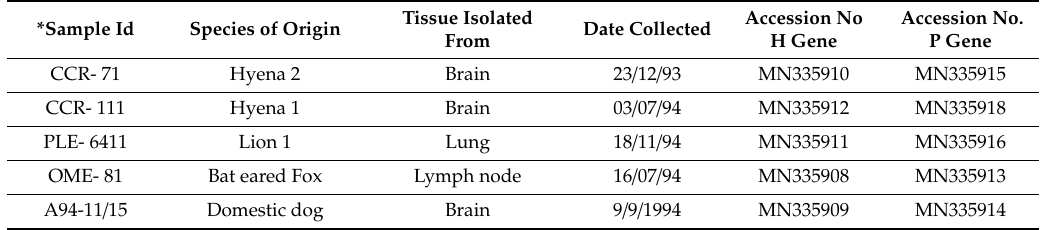
Table 1. Origin of canine distemper virus (CDV)